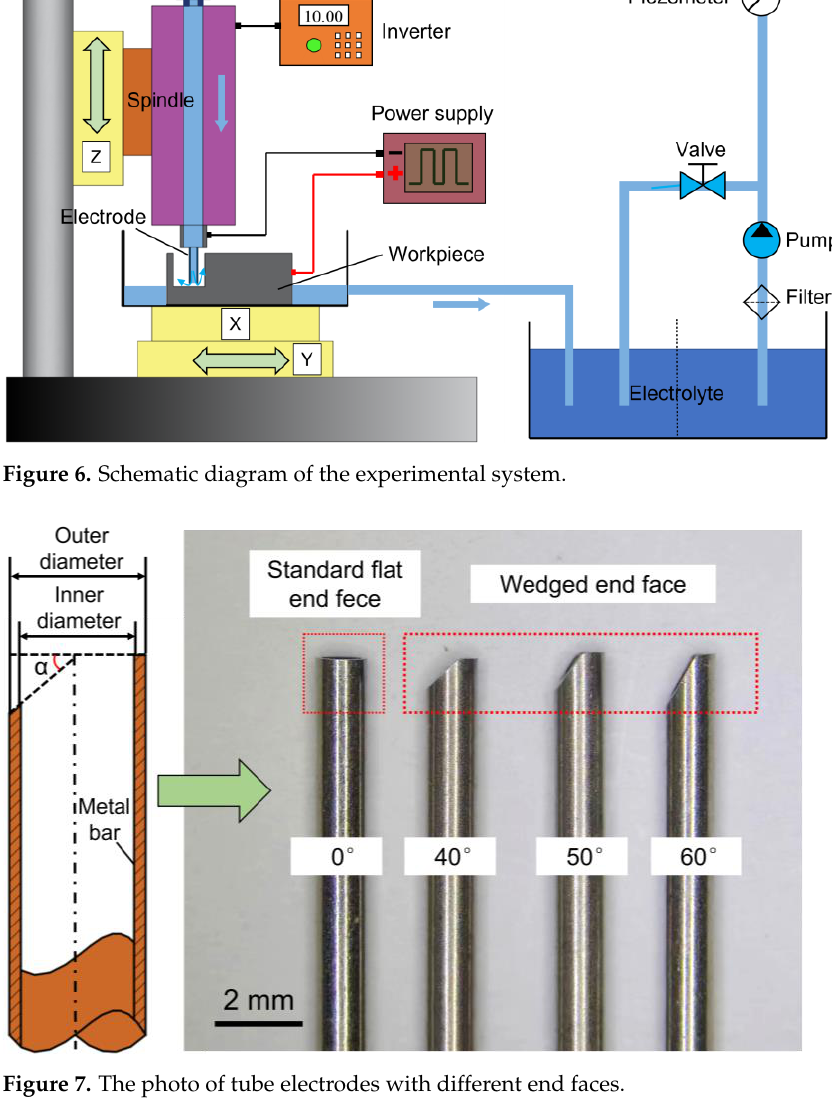
Figure 8. Schematic diagram of deep-narrow groove measurement. Table 2. Machining parameters. Parameters